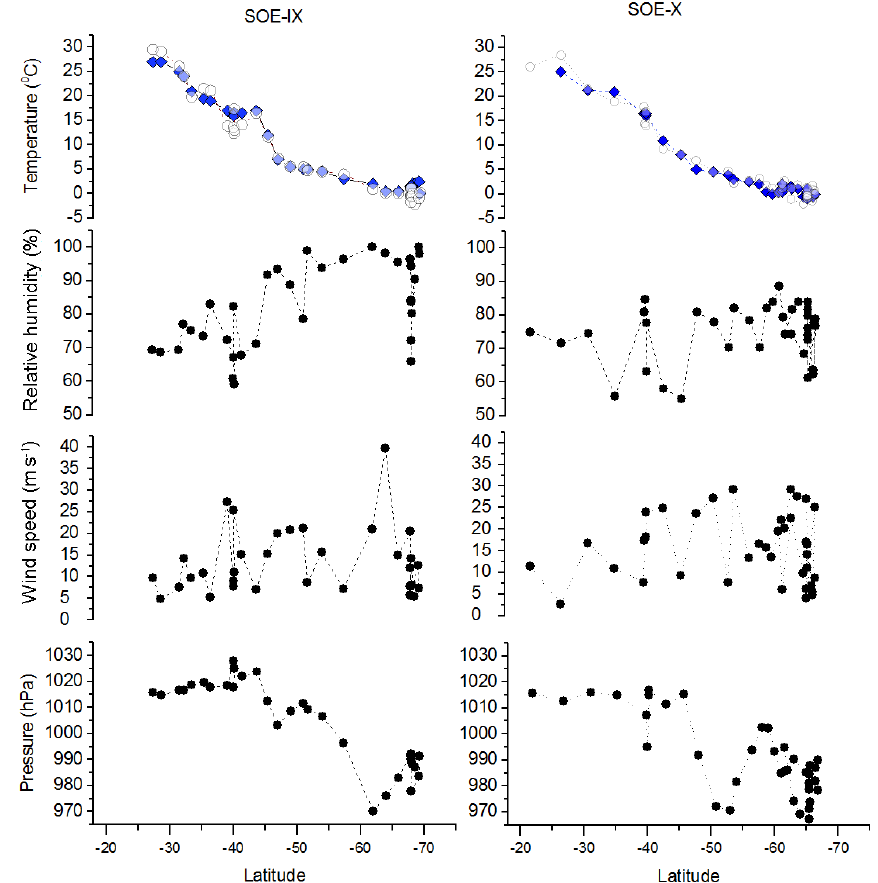
Figure 2. Latitudinal variability in measured meteorological parameters, temperature, relative humidity, wind speed and atmospheric pres- sure. Filled blue diamonds and open circles in the temperature plot represent the sea surface temperature and air temperature,